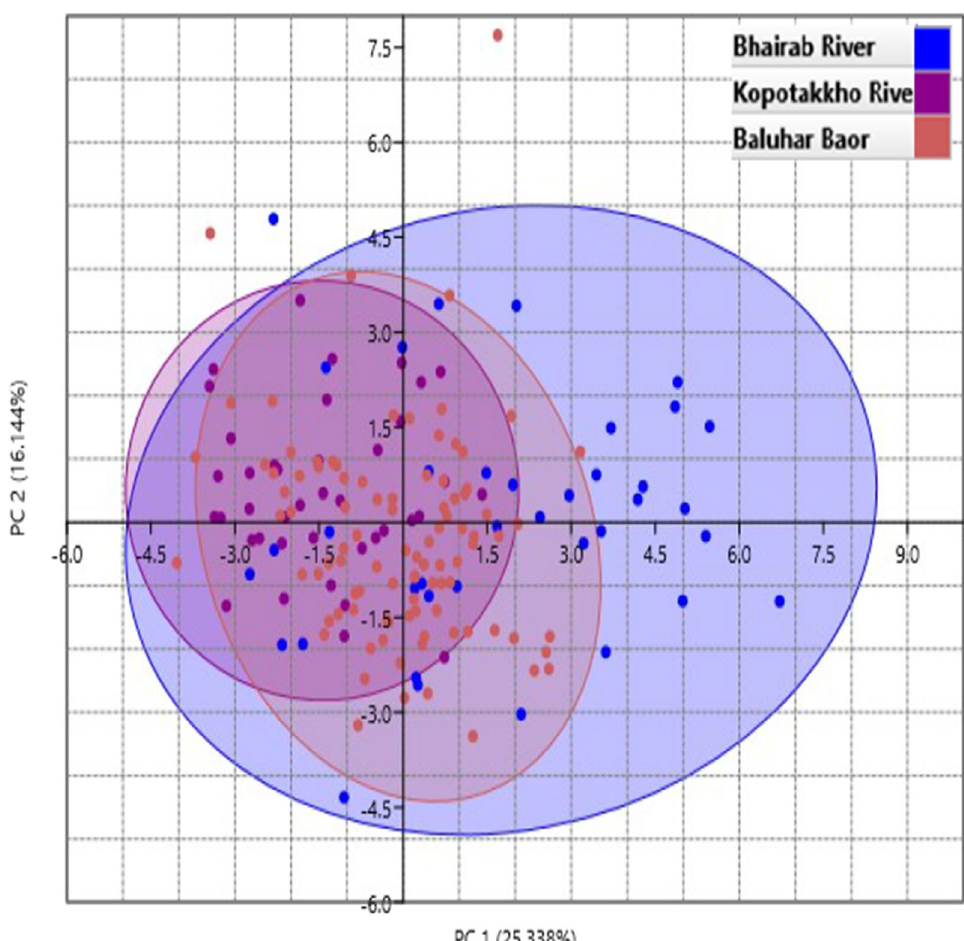
Fig. 5 PCA plot of H. limbatus on the conventional and truss morphometric